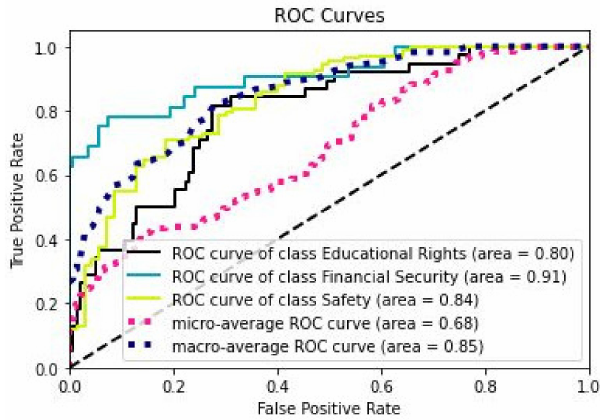
Figure 9. SVC ROC—Aspect classification.